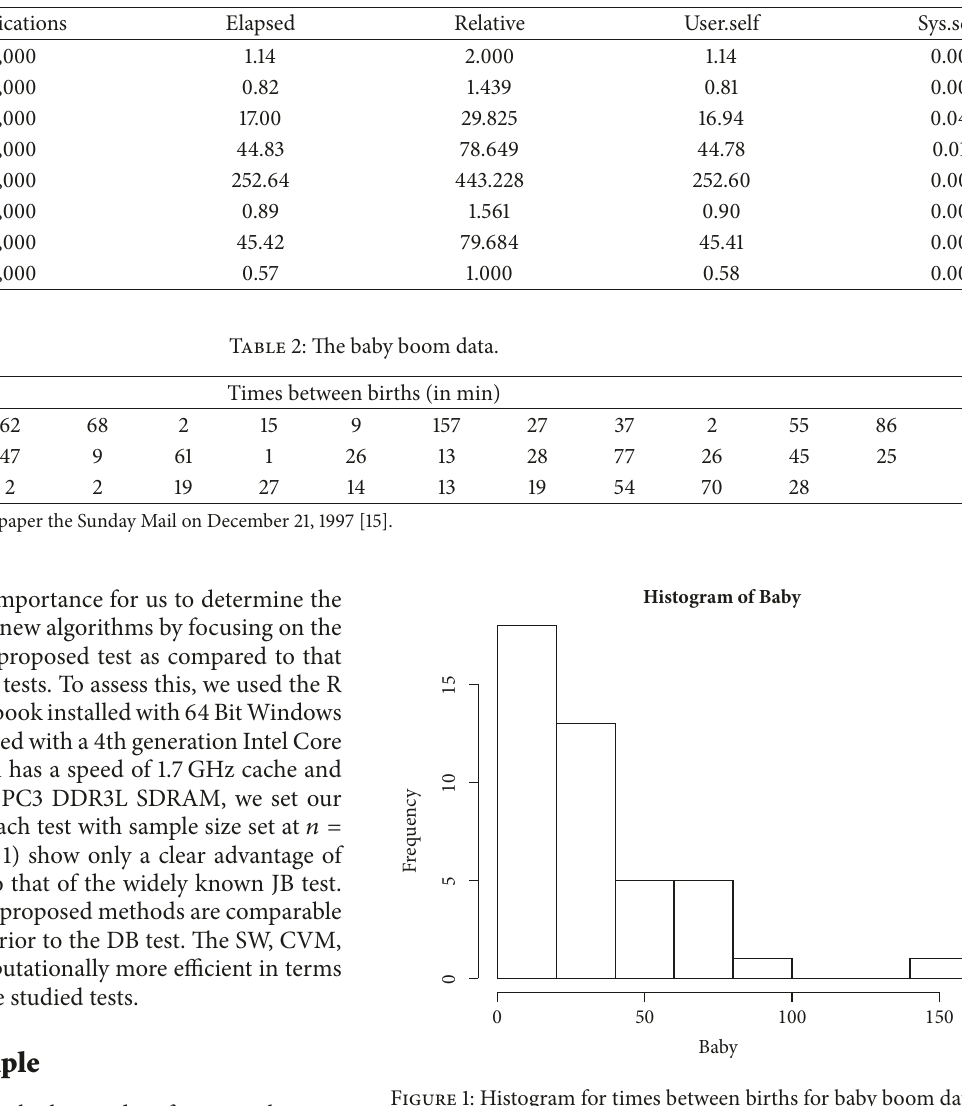
Figure 1: Histogram for times between births for baby boom